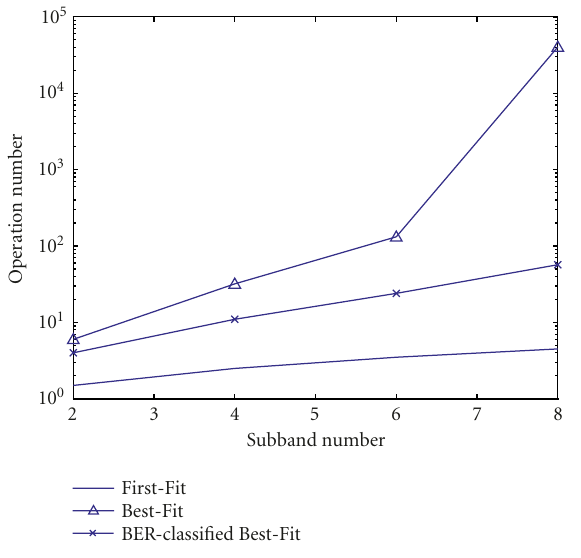
Figure 5: Complexity comparison.